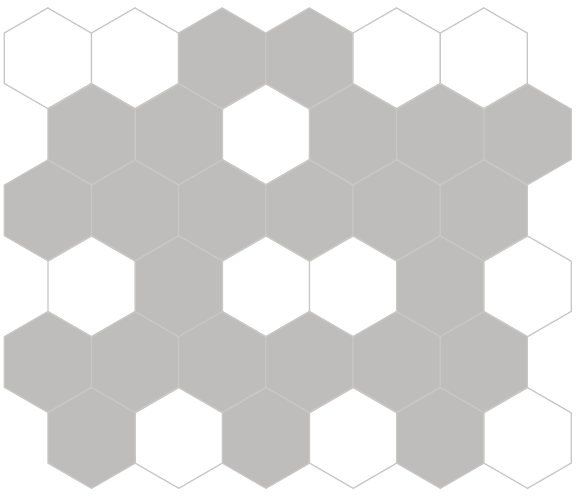
Figure 8: 8 × 8 test network optimal solution with reporting cells